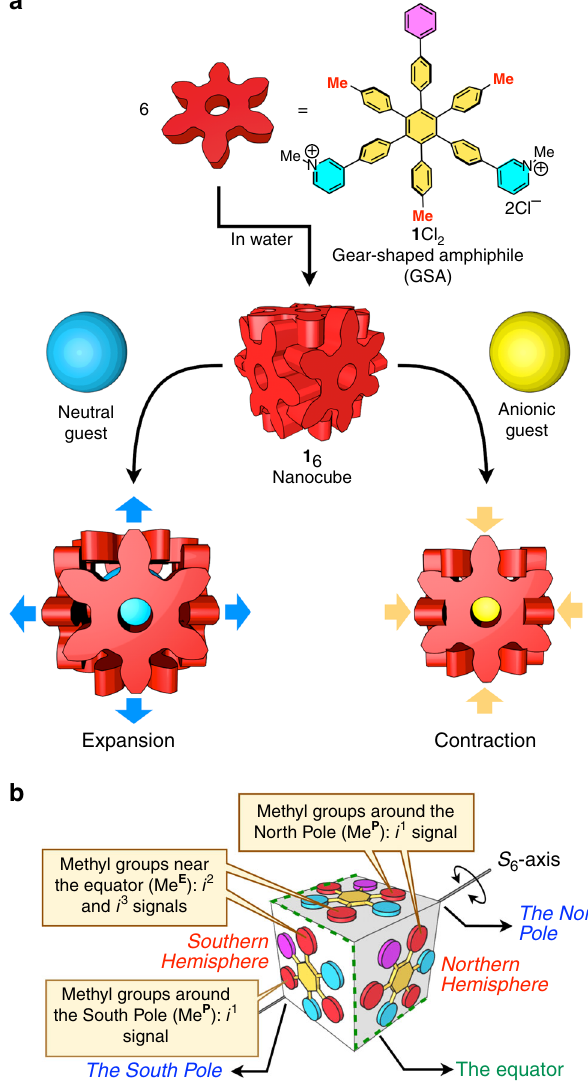
Fig. 1 The expansion and contraction feature of the nanocube. a The expansion and contraction of the 1 6 Cl 12 nanocube assembled from six molecules of 1 Cl 2 by neutral and anionic guests, respectively. b Schematic representation of the structure of the nanocube. The signals i 1 – i 3 indicate the chemically inequivalent p -tolyl methyl 1 H NMR signals of the nanocube in Fig.